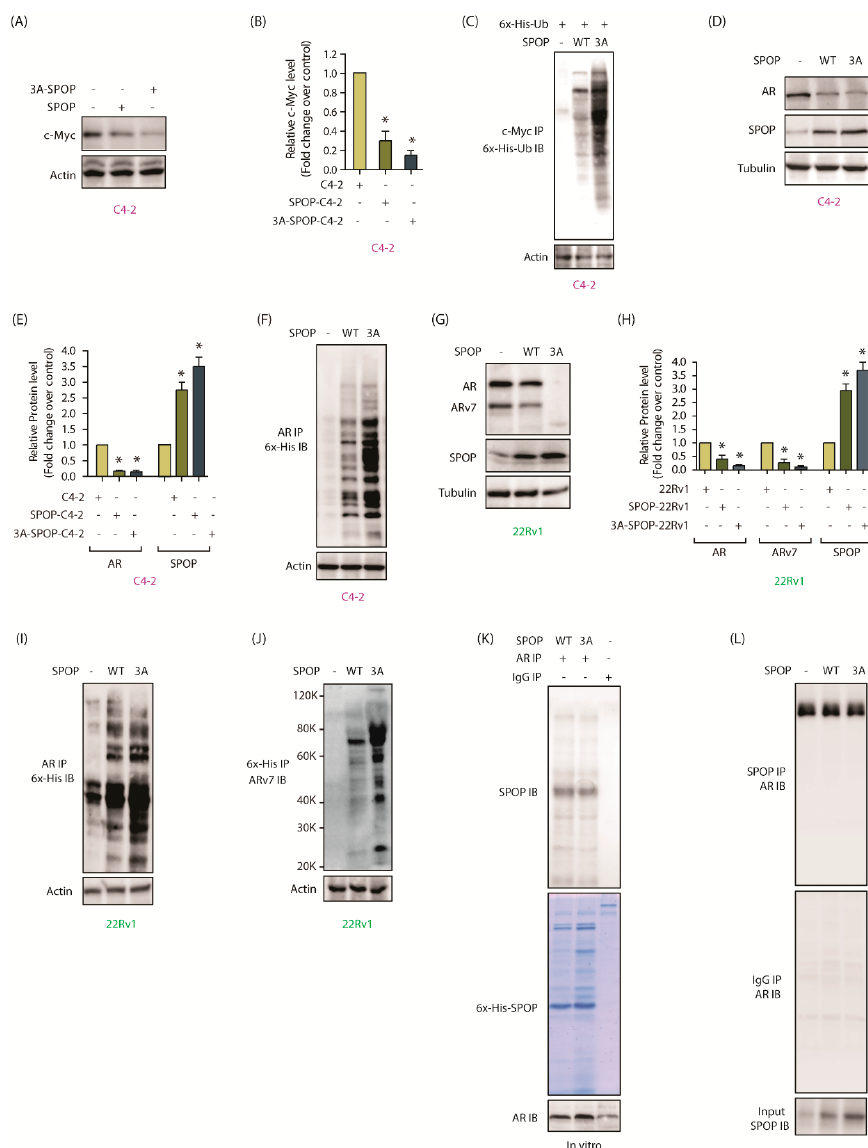
Figure 6. AURKA promotes AR, ARv7 and c-Myc stability by degrading SPOP. ( A ) WT-SPOP and 3A-SPOP decrease c-Myc protein expression levels. ( B ) Histogram shows changes in c-Myc protein levels. The data presented as mean ± SEM obtained from three independent experiments. * p < 0.05 vs. C4-2 control cells. ( C ) 3A-SPOP promotes higher ubiquitylation of c-Myc protein as compared to WT-SPOP. ( D ) Both WT-SPOP and 3A-SPOP decreases AR protein levels in C4-2 cells. ( E ) Histogram shows change in AR and SPOP protein levels. The data are presented as mean ± SEM obtained from three independent experiments. * p < 0.05 vs. C4-2 control cells. ( F ) 3A-SPOP promotes more robust ubiquitylation of AR protein, compared to WT-SPOP in C4-2 cells. ( G ) Ectopic expression of 3A-SPOP decreases AR and ARv7 protein levels more than WT-SPOP in 22Rv1 cells. ( H ) Histogram shows changes in AR and ARv7 protein levels in 22Rv1, SPOP-22Rv1 and 3A-SPOP-22Rv1 cells. The data are presented as mean ± SEM obtained from three independent experiments. * p < 0.05 vs. 22Rv1 control cells. ( I ) 3A-SPOP promotes more robust ubiquitylation of AR in 22Rv1 cells compared to WT-SPOP. ( J ) 3A-SPOP promotes more robust ubiquitylation of ARv7 in 22Rv1 cells compared to WT-SPOP. ( K ) WT and 3A-SPOP bind AR equally well. In vitro pull-down assay using recombinant SPOP and AR proteins were used to check AR and SPOP association. AR on beads was incubated with 6x-His-SPOP (WT and 3A) and binding analyzed. ( L ) SPOP and AR binding in C4-2, SPOP and 3A-SPOP-expressing C4-2 cells. SPOP protein was immunoprecipitated from the above-mentioned cells and AR binding analyzed by immunoblotting (top panel). IgG IP followed by AR IB is shown in the same line in the middle panel. Lower panel shows SPOP levels as